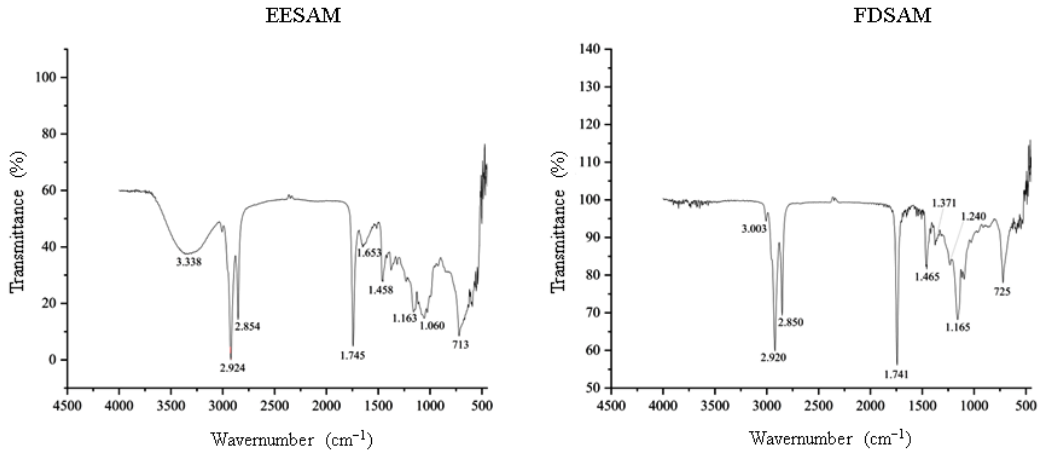
Figure 2. Infrared spectra of the extract and fraction of A. muricata . EESAM—ethanolic extract from seeds; FDSAM—dichlomethane fraction from seeds. Source: Authors.